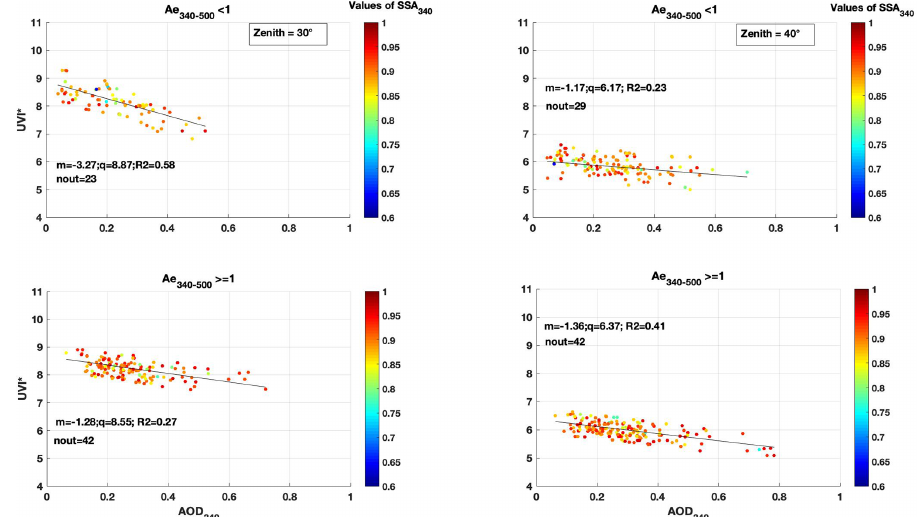
Figure 7. Scatterplot of UVI ∗ vs. AOD 340 for two groups of Ang 340 − 500 values and two solar zenith angles. The colors represent the values of SSA 340 . Note: nout is the number of rejected outliers, m is the slope, and q is the intercept value.